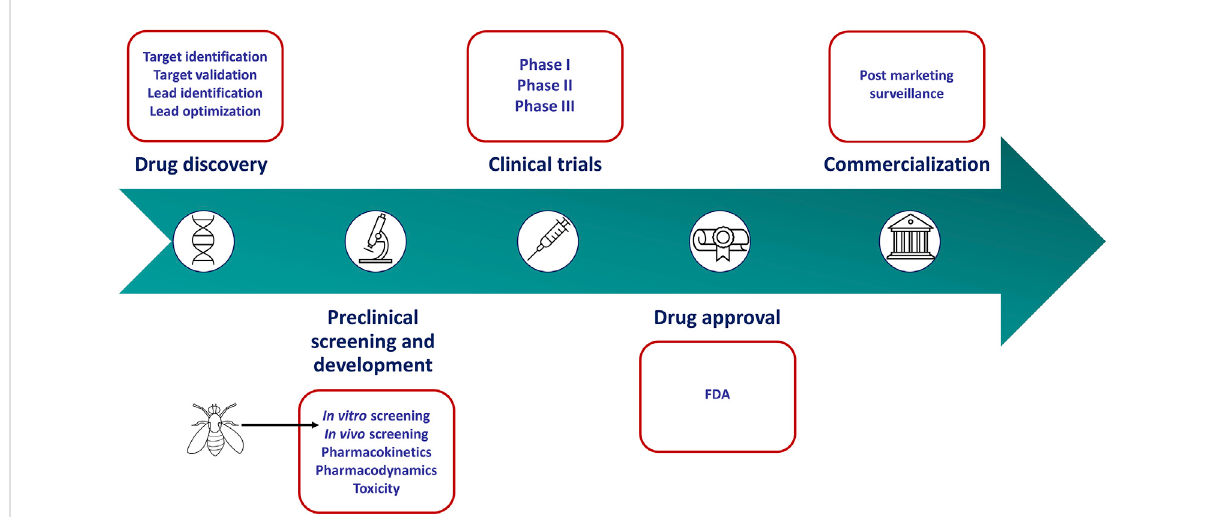
FIGURE 1 Drug discovery and development pipeline. In vitro culture screens have become a standard tool used in the preclinical stages to identify anticancer agents. However, these models fail to mimic key characteristics of human tumors. Drosophila melanogaster can recapitulate these characteristics more accurately and may serve as a more appropriate screening tool in the preclinical stages of the drug discovery